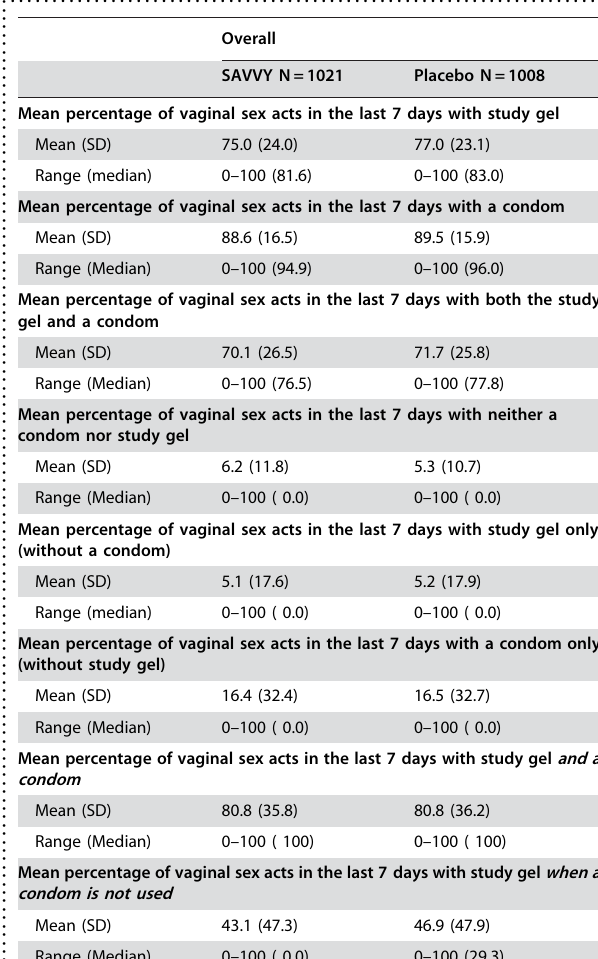
Table 2. Overall Estimates of Gel and Condom Use at Follow-